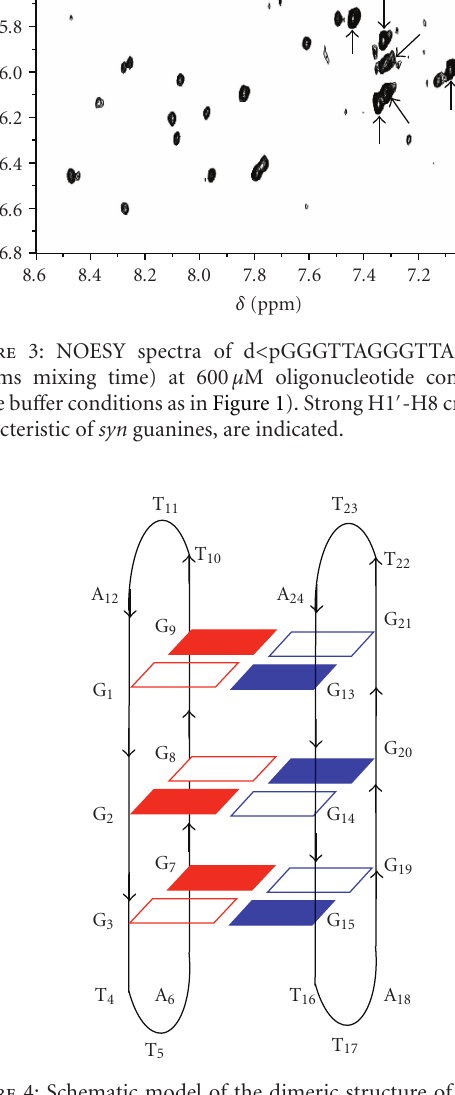
Figure 4: Schematic model of the dimeric structure of d < pGGG- TTAGGGTTA > , consistent with the experimental data in Na + bu ff er. Guanines syn and anti are indicated with open and solid rectangles,